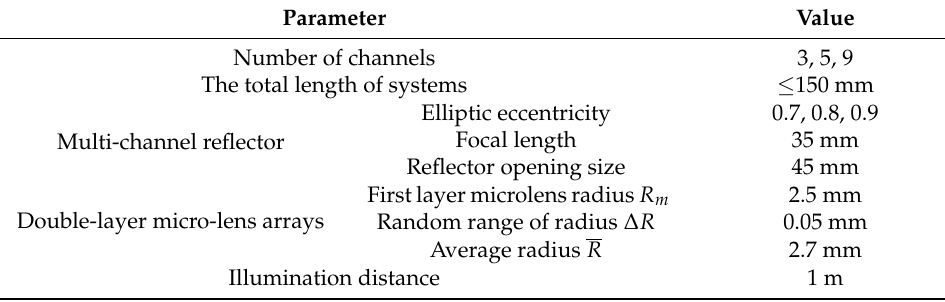
ones from the previous study [16]. The light sources of the optical systems are OSRAM RGBW LEDs (LE RTDUW S2WN). The light source is located at the focal point of each channel. The number of LEDs installed can be increased by increasing the number of channels. The optical model with three channels and the position of the light source in the system is shown in Figure 6.